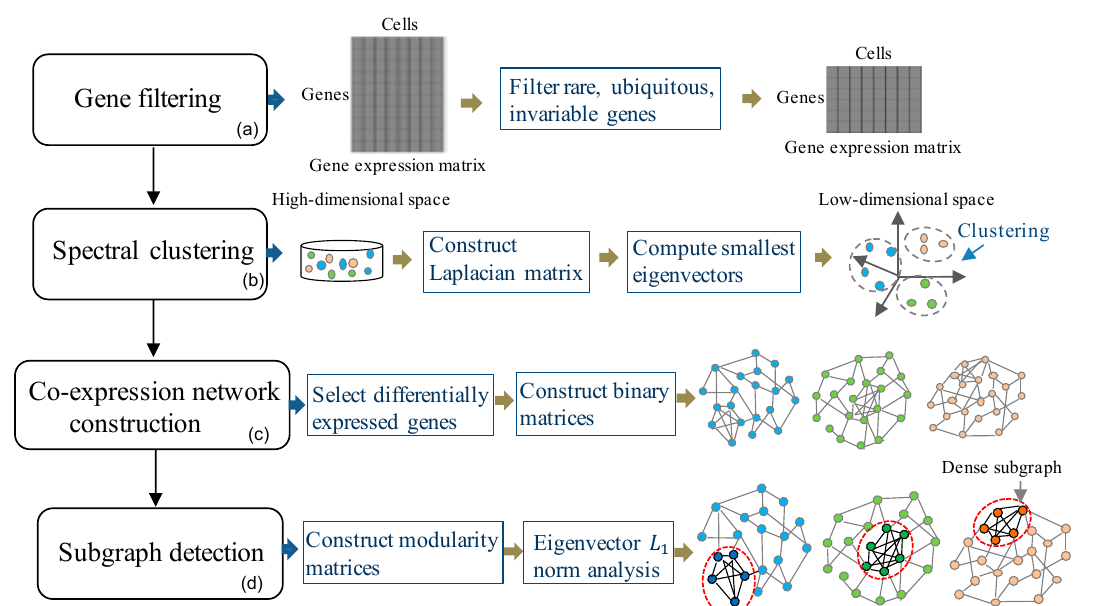
Figure 1. The proposed learning framework to detect interactive gene groups. Four major steps: ( a ) Filtering rare, ubiquitous, and invariable genes; ( b ) Spectral clustering to identify cell subpopulations; ( c ) Constructing gene co-expression networks; ( d ) Detecting dense subgraphs embedded in the gene co-expression